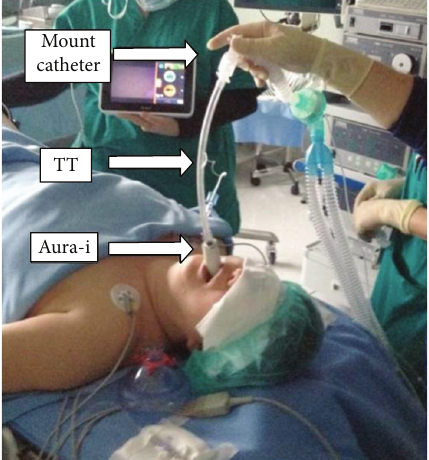
Figure 1: The patient is mechanically ventilated through a tracheal tube (TT) partially inserted in the airway tube of Aura-i and with the cuff